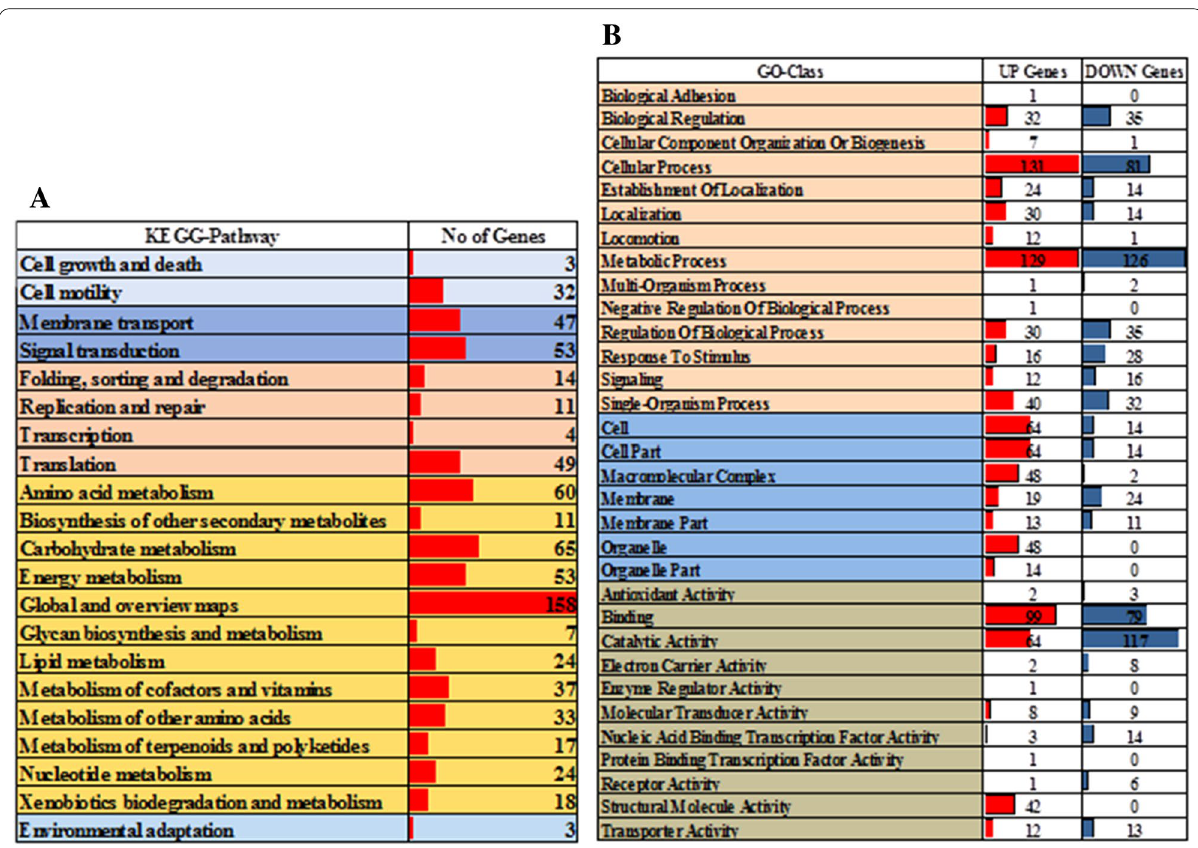
Fig. 4 The total number of differentially expressed significant genes obtained from RNA-Seq with a enriched KEGG pathways and b Gene ontology (biological process, cellular component, and molecular